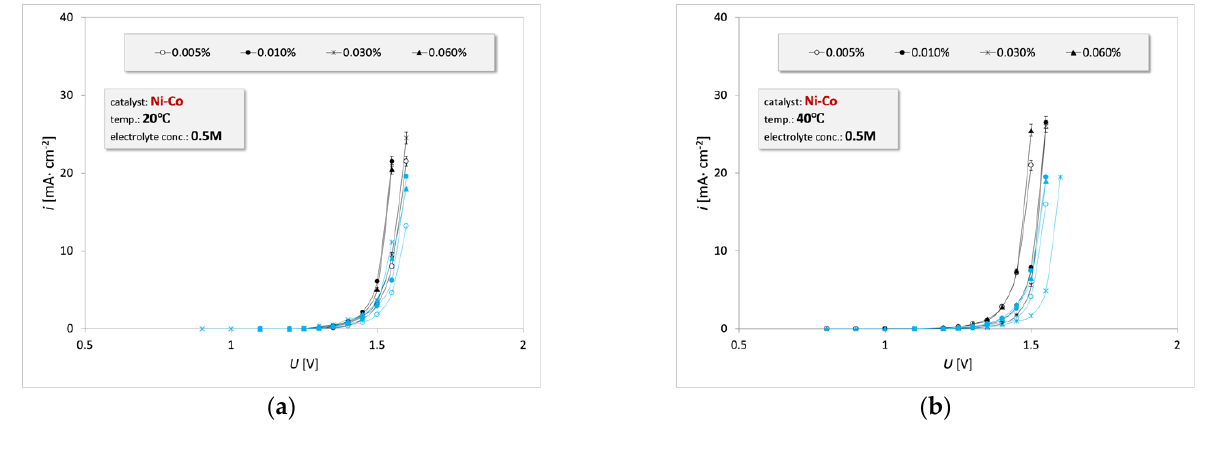
Figure 6. Electrooxidation curves of WEO emulsion (black lines) and detergent (blue lines) for various concentrations of detergent and emulsion on the Ni-Co catalyst for an electrolyte concentration of 0.5 M. Electrooxidation: ( a ) temperature: 20 °C; ( b ) temperature: 40 °C.